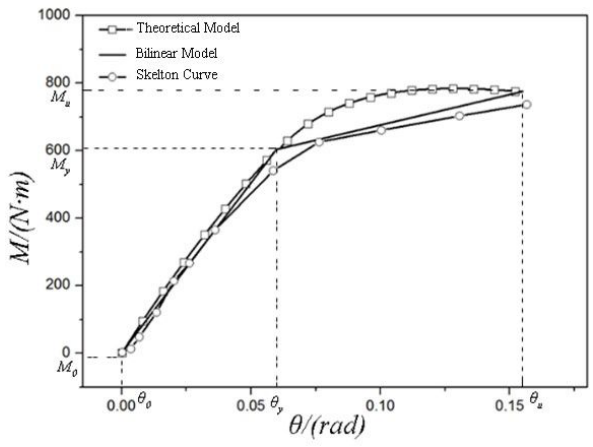
Figure 8: Comparison of experiment, theoretical model and